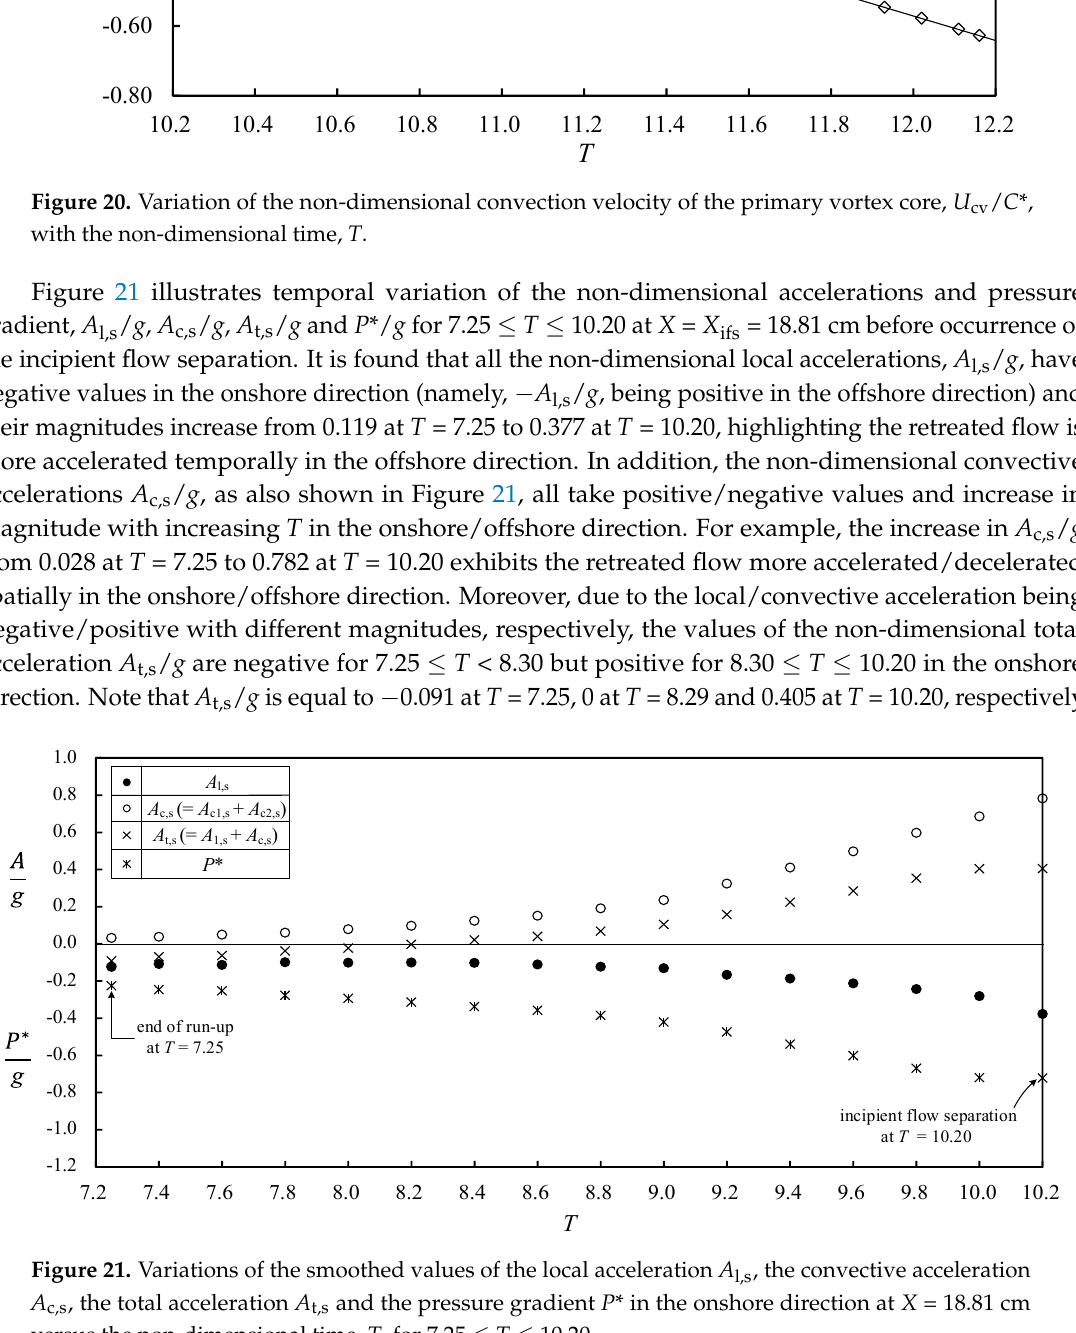
Figure 20. Variation of the non-dimensional convection velocity of the primary vortex core, U cv / C *, with the non-dimensional time, T .